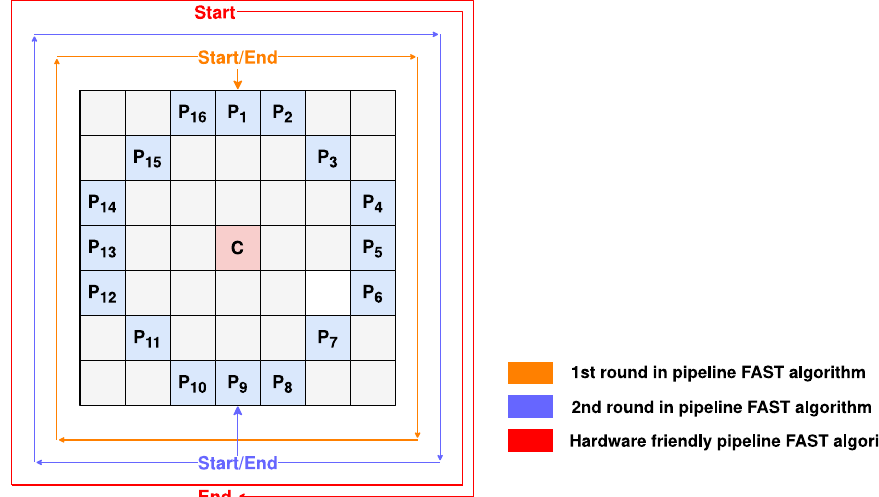
Figure 4. The hardware-friendly pipeline FAST algorithm.